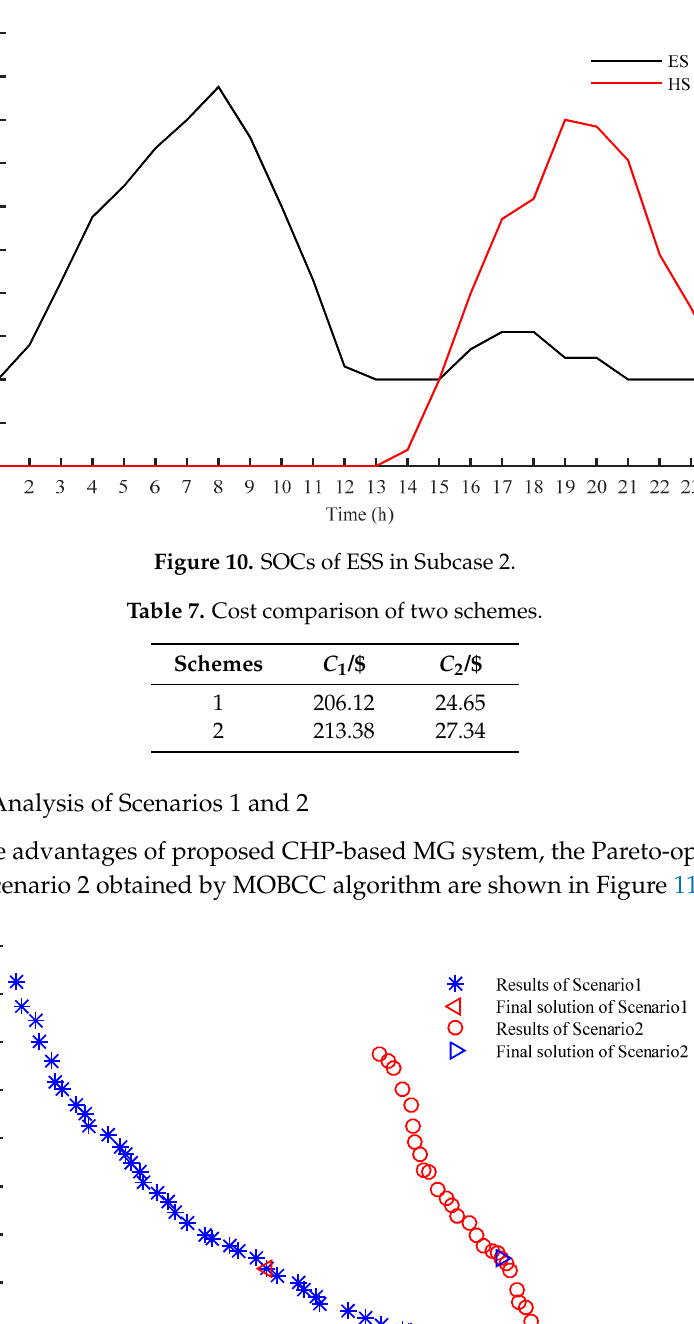
Figure 9. SOCs of ESS in Subcase 1.